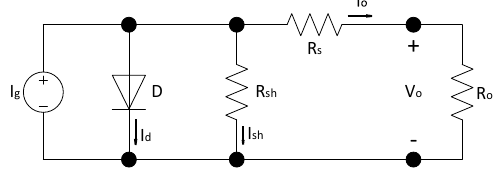
Figure 2. The equivalent circuit of a photovoltaic (PV) module [30].